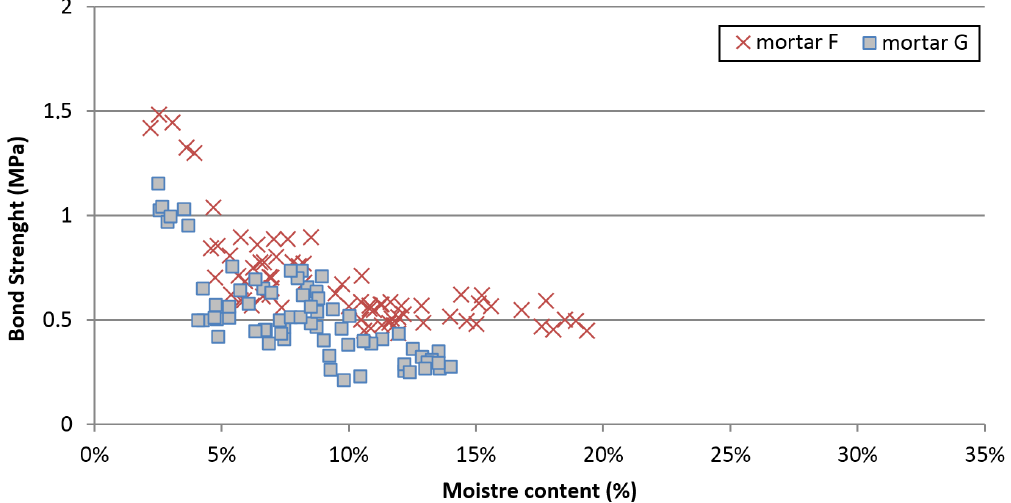
Figure 7. Variation of the moisture content on the bond strength during